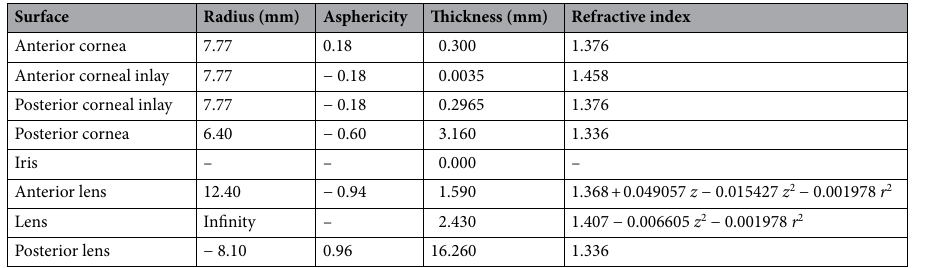
Table 1. Liou–Brennan model eye Zemax data sheet ( r and z are radial and axial coordinates in the crystalline